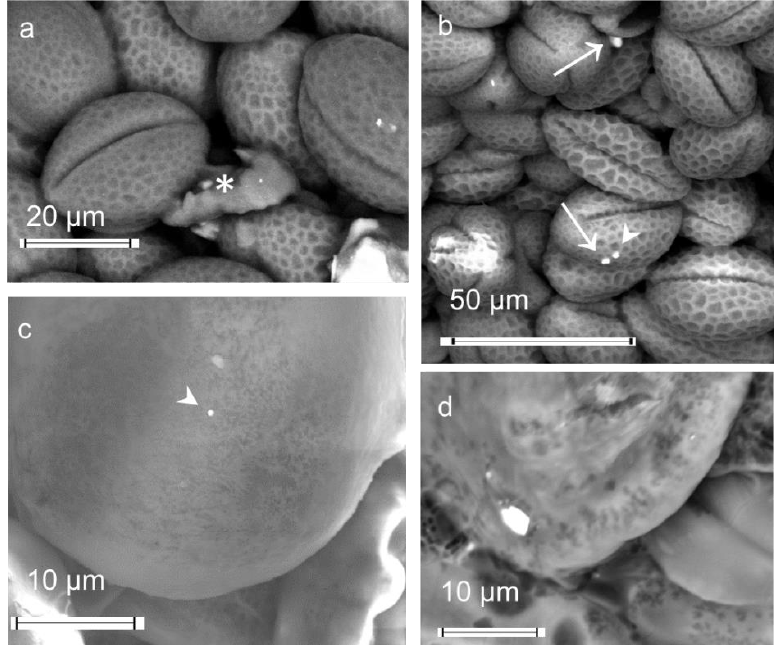
Figure 4. ( a ) Particulate matter (PM) of feldspar (asterisk). ( b ) Particles of Fe-Cr-Mn (arrows, 1.3 µ m and 2.7 µ m) and Fe oxides/hydroxides (arrowhead, 1 µ m). ( c ) a submicrometric PM of Fe-Cr (arrowhead, 200 nm). ( d ) a particle of Fe-Cr-Mn (6.3 µ m). Corresponding EDX spectra are provided as Supplementary Materials.